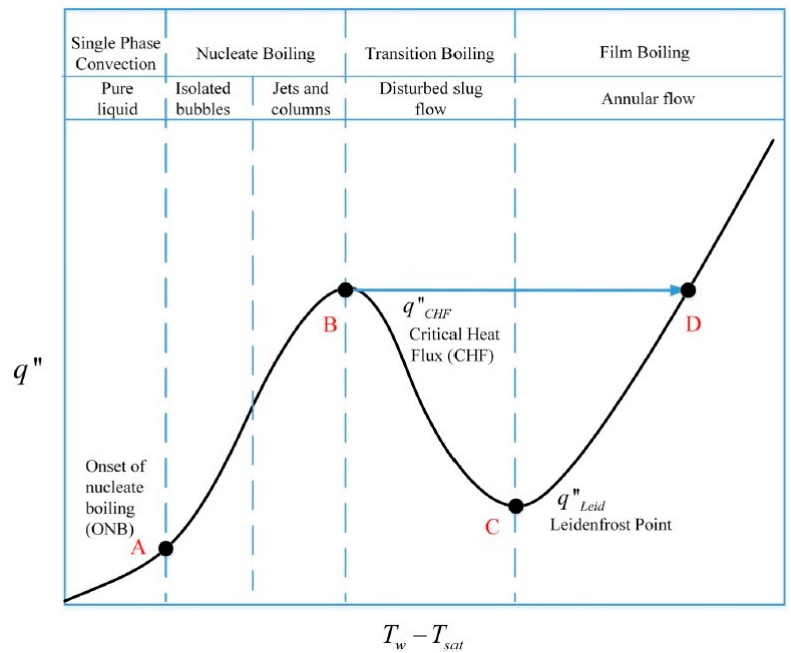
Figure 1. Boiling curve of water (Reprinted from Ref. [17])